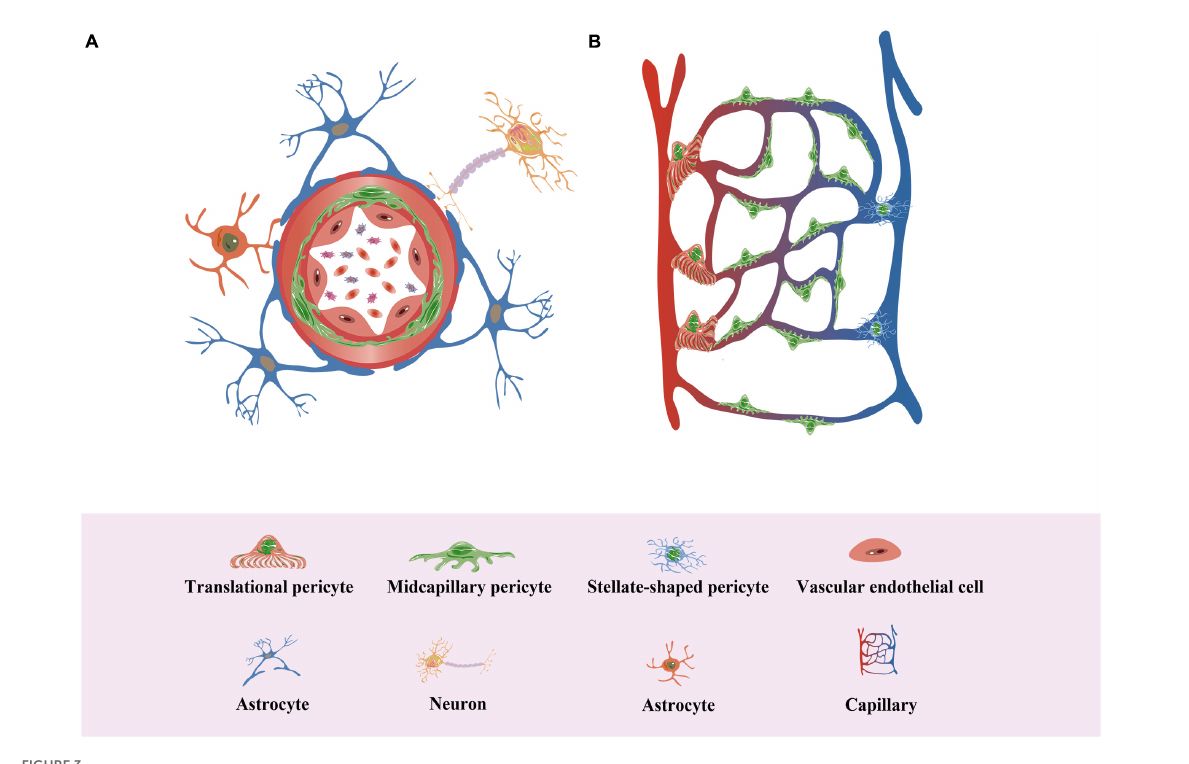
FIGURE3 Pericytes in neovascularization. (A) Pericytes surround the endothelium in the vessel wall and are typically embedded in and linked to the basement membrane of the vessel. (B) Pericytes are a population of cells with various subtypes, including “Transitional pericyte”, which has more annular protrusions at the ends of small arteries in the capillary bed, “Midcapillary pericyte”, which has more longitudinal protrusions, and “Stellate-shaped pericyte”, which has more stellate protrusions at the ends of small veins in the capillary